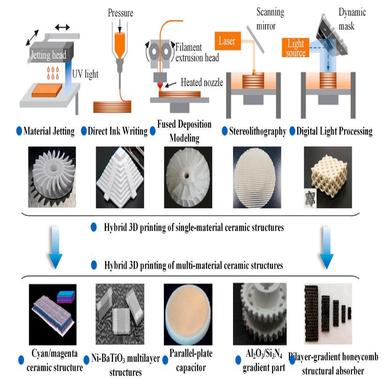
Schematic diagram applying to multi-material ceramic additive manufacturing techniques and their application in single and multi-material ceramic structures.